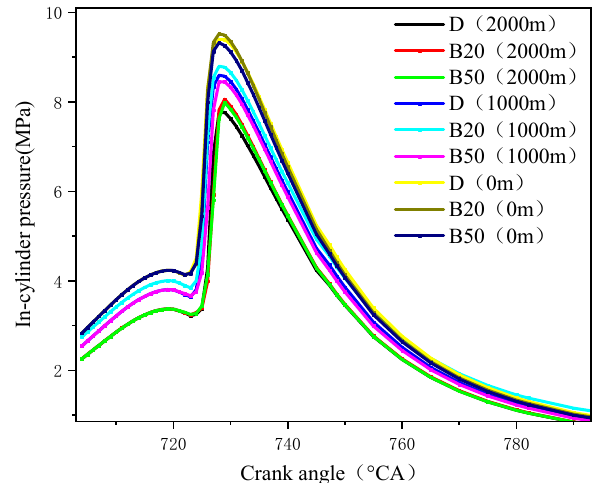
Figure 5. Effect of different plateau environments on pressure of cylinder with different blending ratios.